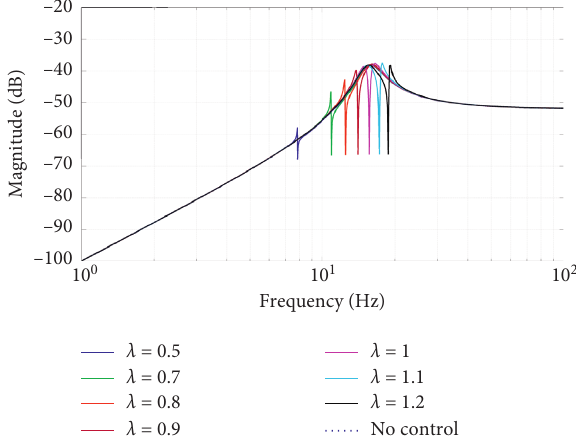
Figure 3: Logarithmic amplitude-frequency characteristic curves of the structure with and without the FATMD (varying λ